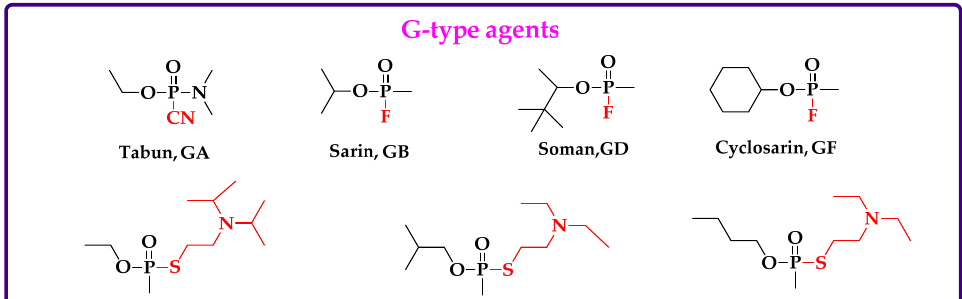
Figure 1. Common G-series or V-series OPNAs and their